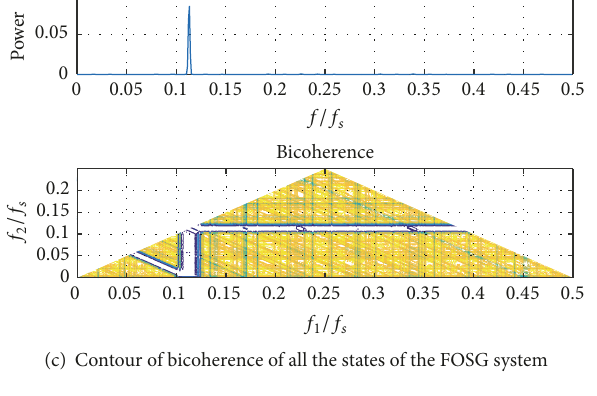
(c) Contour of bicoherence of all the states of the FOSG system Figure 10: Bicoherence of FOSG